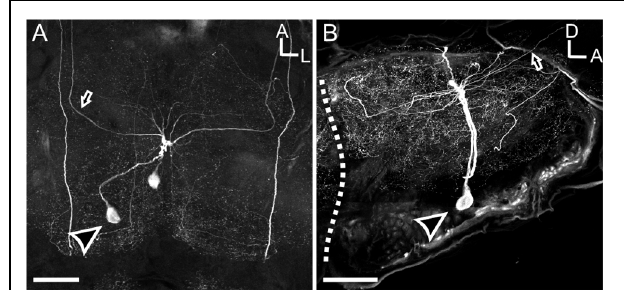
FIGURE 3 | Mesothoracic deutocerebrum histamine neurons processes radiate laterally throughoutthe MsG, but are primarily restricted to the dorsal aspect. (A) Horizontal view of the MSG showing two cell bodies with each cell projecting out one side of the ganglia. (B) Sagittal section of the MsG shows two large HA-ir cells with cell bodies (black arrow head with a white outline) situated ventrally and a radiating dendritic field dorsally with the axon (black arrow with white outline) projecting up the connective between the mesothoracic and prothoracic ganglia. White dotted line indicates the boundary between the mesothoracic and metathoracic ganglia. Arrow indicates MDHn cell body in each image. All scale bars = 100 μ